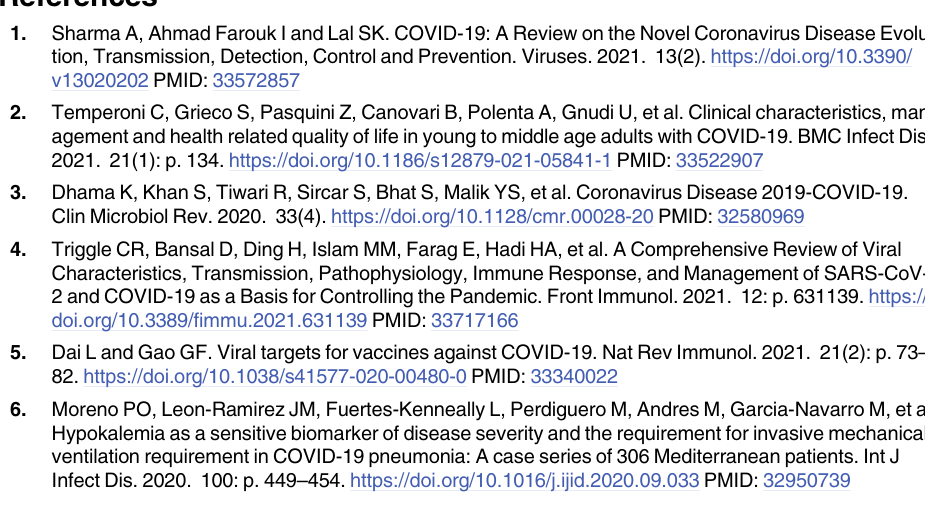
S1 Table. Clinical Symptoms of the included patients (%). S2 Table. Hypokalemia was not associated with prolonged days of negative nucleic acid conversion between FNC group and SNC group. Model 1: Unadjusted model. Model 2: Adjusted for age. Model 3: Adjusted for variables included in model 2 + WBC, lymphocyte, and serum calcium ion. S3 Table. Hypokalemia was associated with prolonged hospital stay. Model 1: Unadjusted model. Model 2: Adjusted for